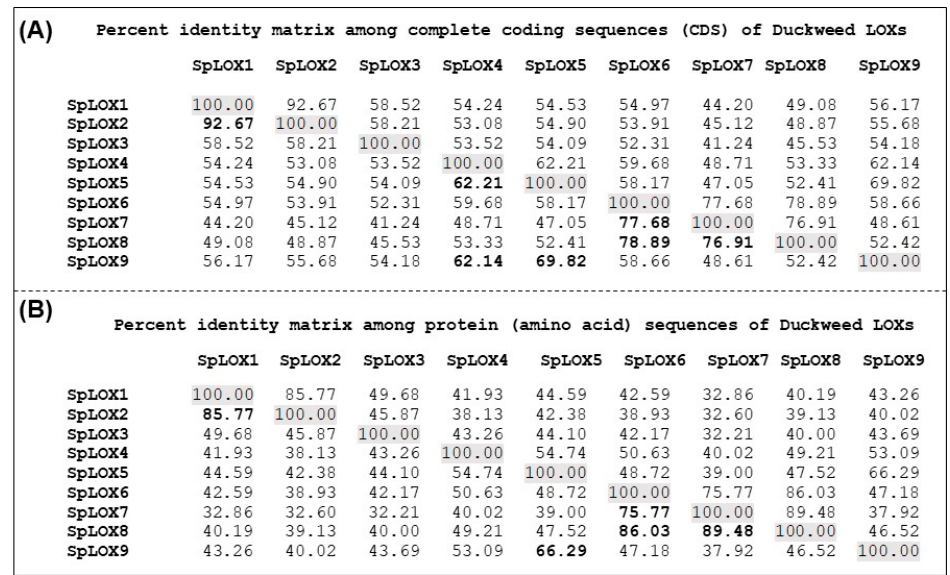
Figure 4. Spirodela LOX sequence identities. ( A ) Coding DNA sequence and ( B ) protein sequence identity matrices were generated using EMBOSS stretcher (https://www.ebi.ac.uk/Tools/psa/emboss_stretcher/). The values in bold face are discussed in the text.